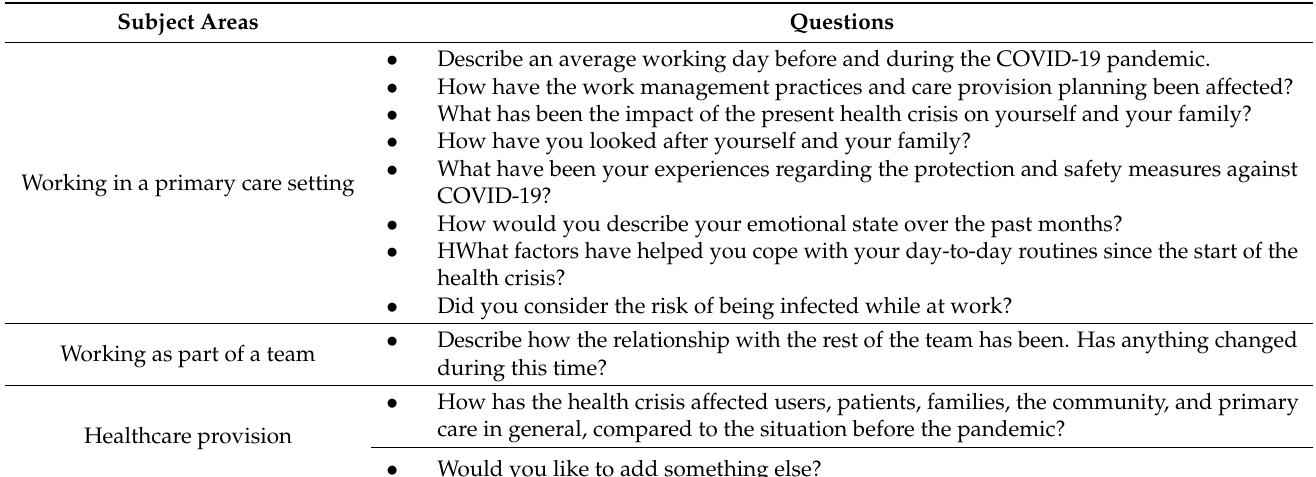
Table 2. Interview